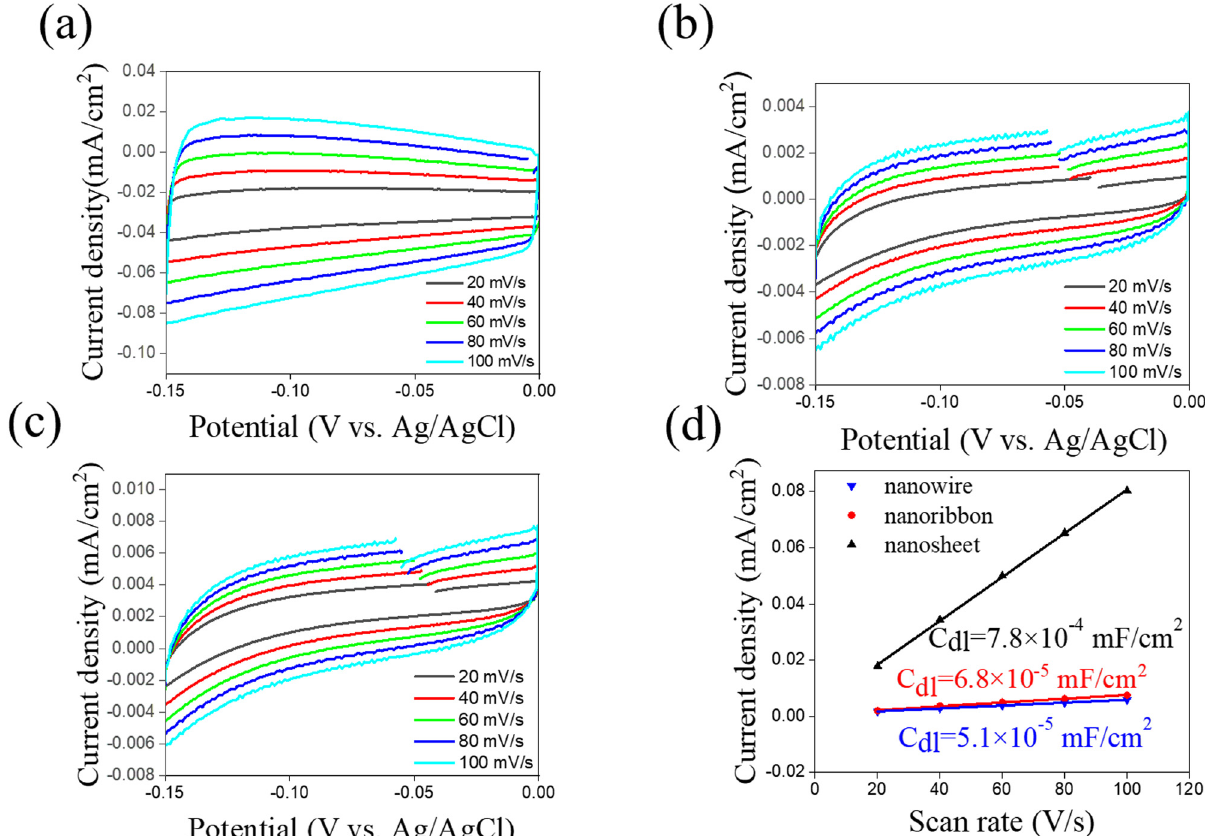
Figure 6: CV curves at various scan rates of di ff erent Bi 2 S 3 products: ( a ) nanosheet, ( b ) nanoribbon, and ( c ) nanowire. ( d ) The fi tted C dl results of various Bi 2 S 3